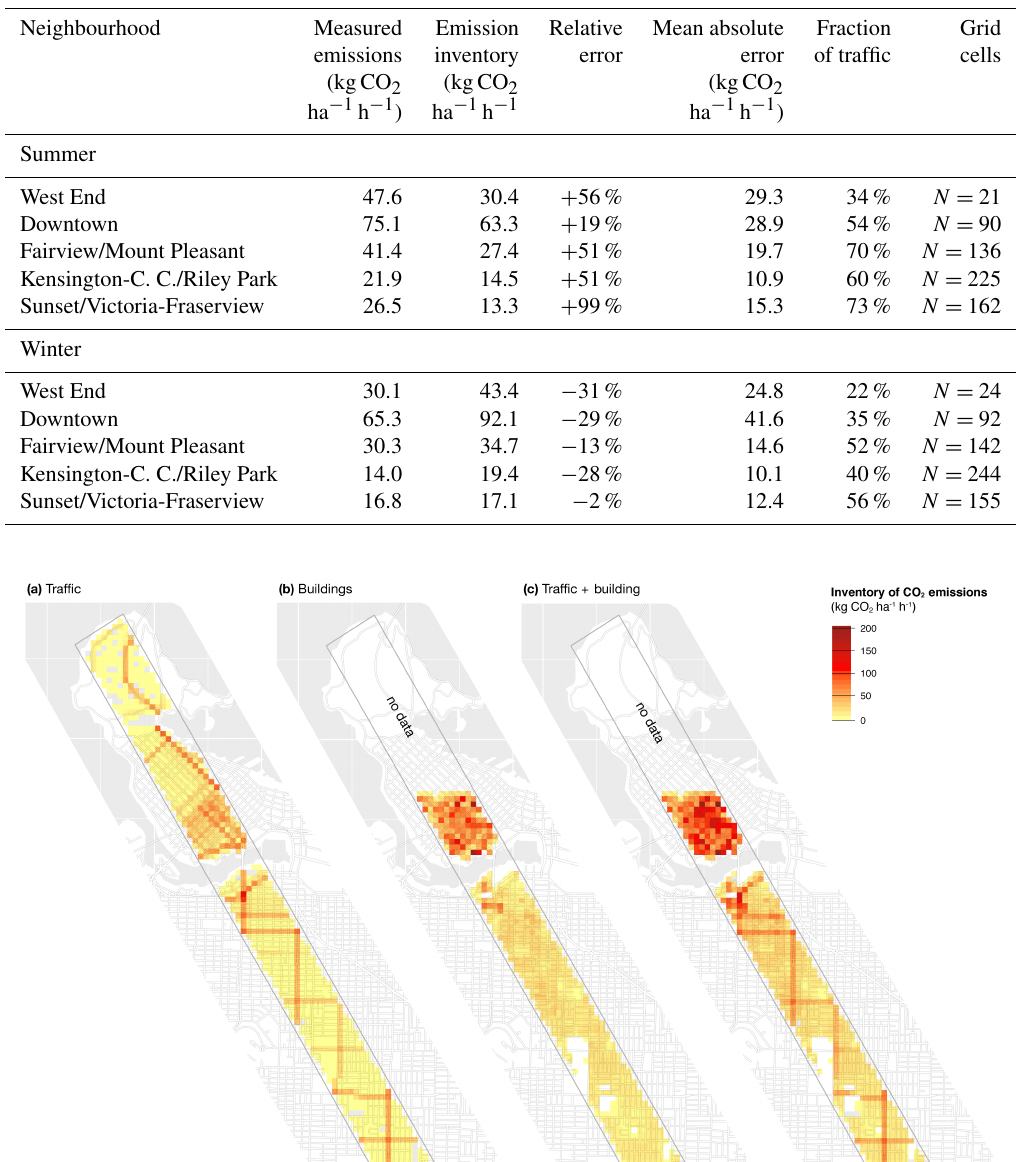
Table 3. Comparison of measured emissions, with inventory emissions, separated by neighbourhood based on a 100 × 100m grid. Neighbourhood